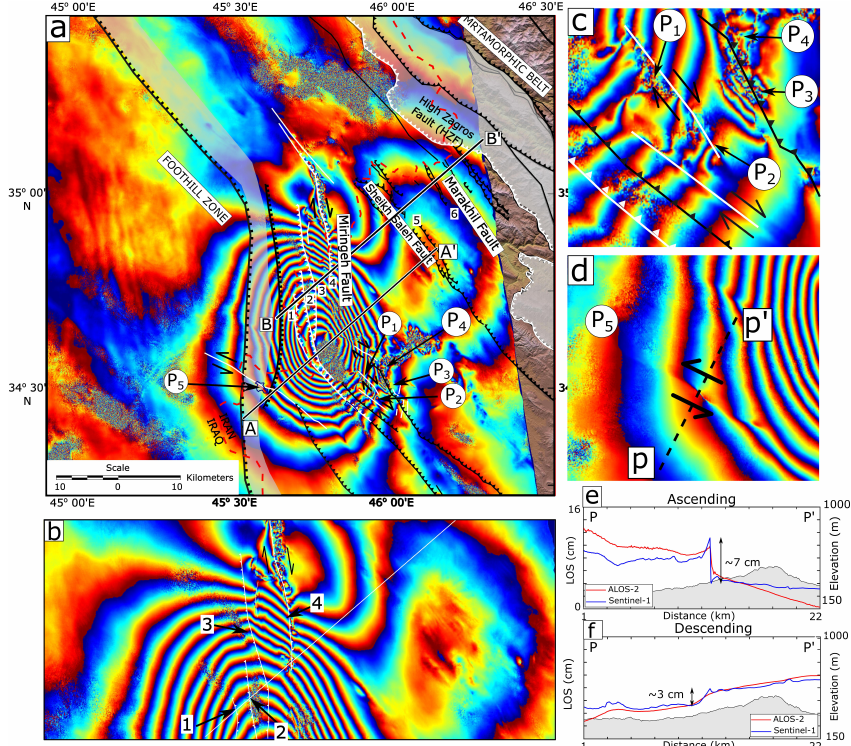
Figure 9. ALOS-2 coseismic ascending interferogram overlaid by pre-existing and recent structures of the area ( a ). Line AA’ in this figure shows the location of the profile plotted in Figure 8. ( b ) Close-up view of the interferograms in the area of the seismic profile, BB’ in (a), presented by Tavani et al. 2018 [24]. Numbers 1, 2, 3, and 4 are fault traces extracted after detailed geological interpretation based on DEM and Sentinel-2 data (See also Figure 1). ( c , d ) Close-up views of some of the areas affected by rockfalls and landslides; P1–P5 are the locations of field surveys. ( e , f ) Profiles along PP’ over the residual